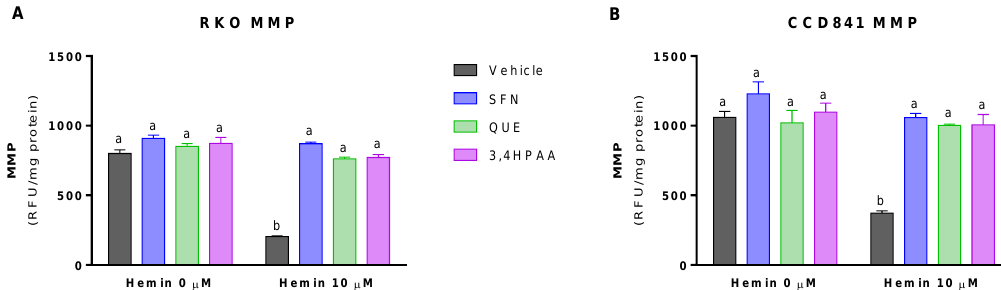
Figure 5. E ff ect of hemin, SFN, QUE and 3,4HPAA in MMP. Cells were incubated with vehicle (0.4% DMSO), 1 µ M SFN, 10 µ M QUE or 2.6 µ M 3,4HPAA in the absence or presence of 10 µ M hemin. After 72 h, MMP was measured by fluorescence in ( A ) RKO; and ( B ) CCD841 cell supernatants. Results were expressed as RFU / mg of protein. Values are expressed as mean ± SEM, from three independent culture preparations. For all bars with the same letter, the di ff erence between the means is not statistically significant. The values with di ff erent letters indicate significant di ff erences ( p < 0.05) between bars (two-way ANOVA, Bonferroni post-test3,4HPAA, 3,4-dihydroxyphenylacetic acid; MMP, mitochondrial membrane potential; QUE, quercetin; SFN, sulforaphane; RFU, relative fluorescence unit.